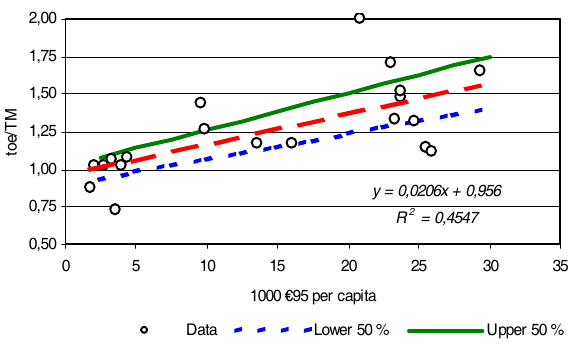
Fig 12. Average fuel consumption in transport means in 1997–2003, depending on GDP per capita Table 3. Forecasts of fuel consumption in road transport (basic scenario) by transport means function